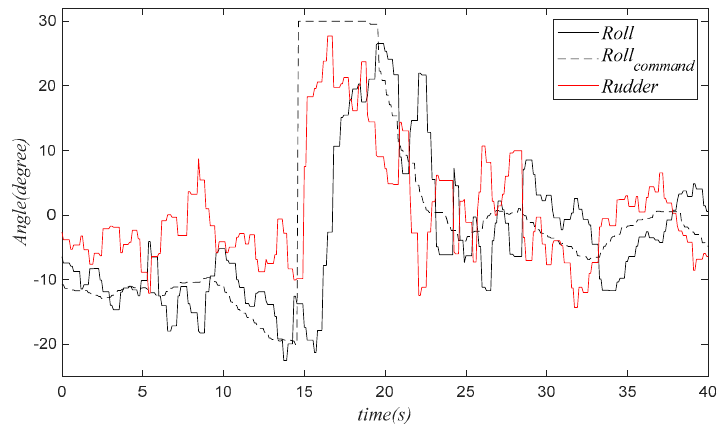
Figure 19. Rudder—roll angle response.